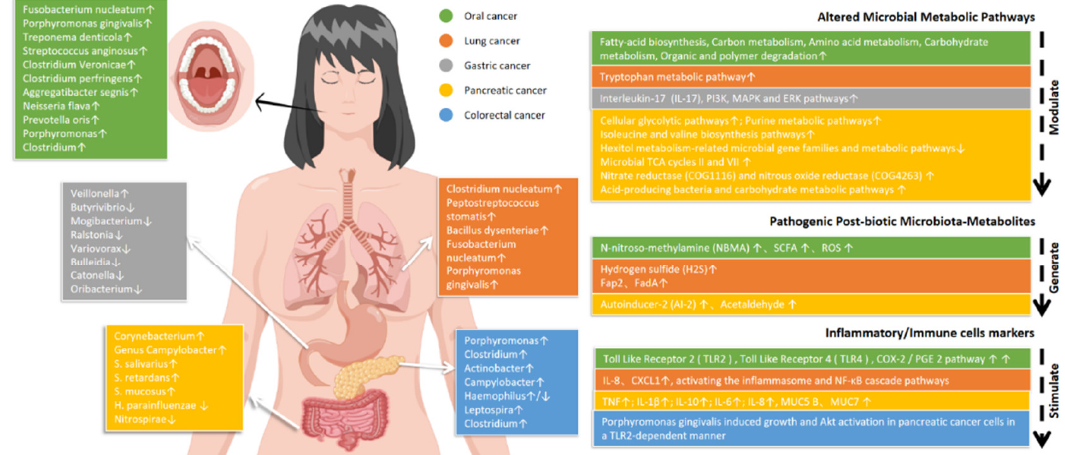
Figure 1. Oral Microbiota; Microbiota—metabolites and inflammatory markers in tumors of various sites. Locations are denoted by the following color code. IL: interleukin; SCFA: short-chain fatty acids; ROS: reactive oxygen species; TNF: tumor necrosis factor; CXCL: C-X-C motif chemokine; ↓ : decreased level; ↑ : increased level. Oral microbiota may be transmitted distally through the bloodstream and digestive tract. Figure 1 shows the changes in oral microbiota, microbial metabol-